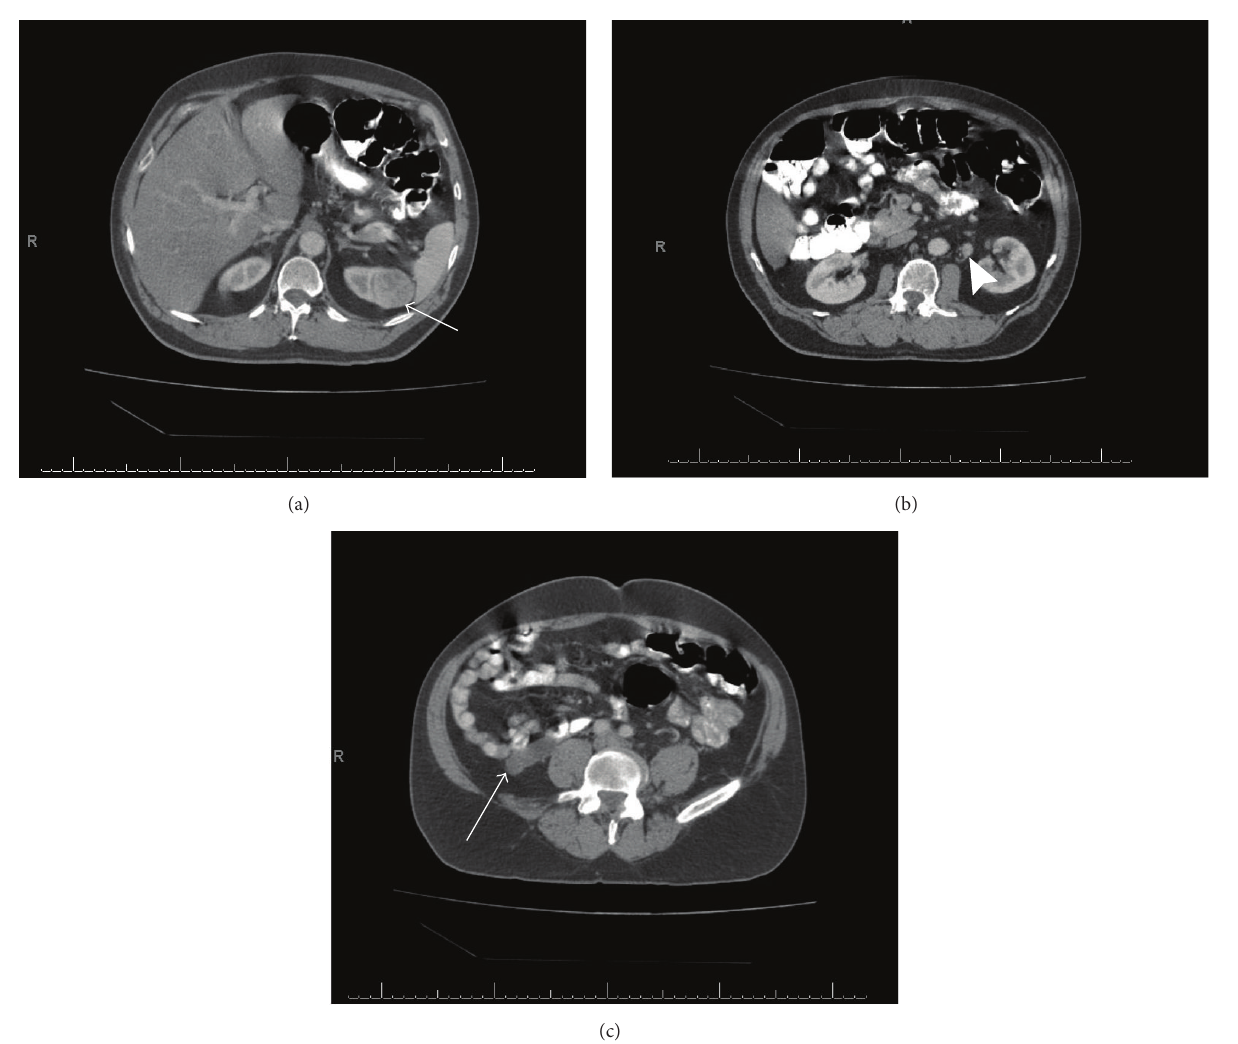
Figure 3: CT scans reveal a partially enhancing mass ((a) arrow) located on the upper pole of the left kidney. The presence of para-aortic lymphadenopathy ((b) arrowhead) as well as a prominent appendiceal mass ((c) arrow) was also